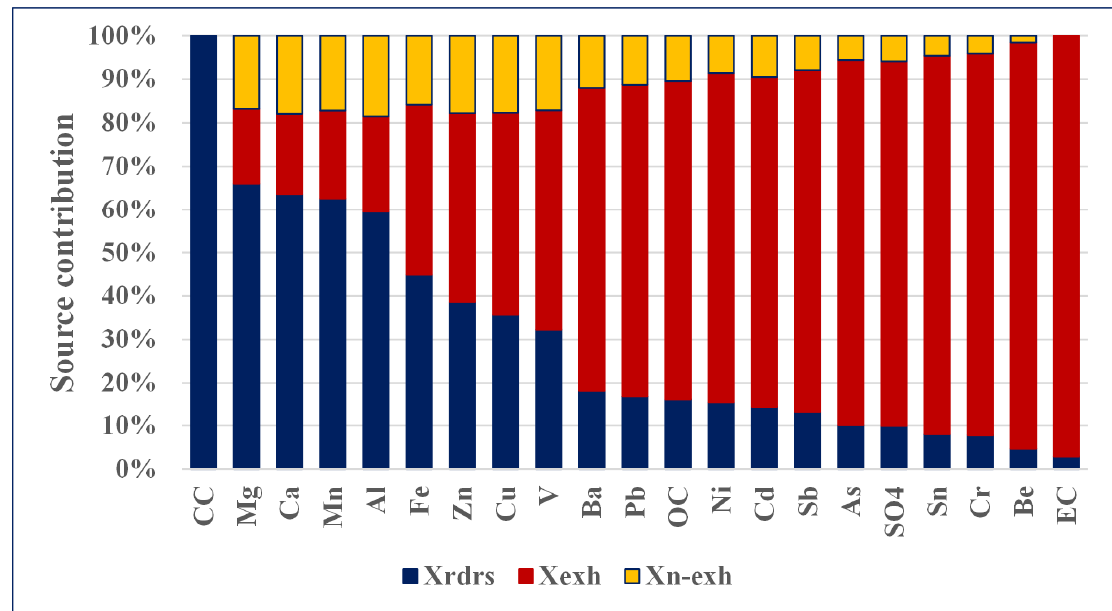
Figure 1. Elemental contributions of rdrs , exh , and n ‐ exh sources on the tsp concentrations of elements (%).